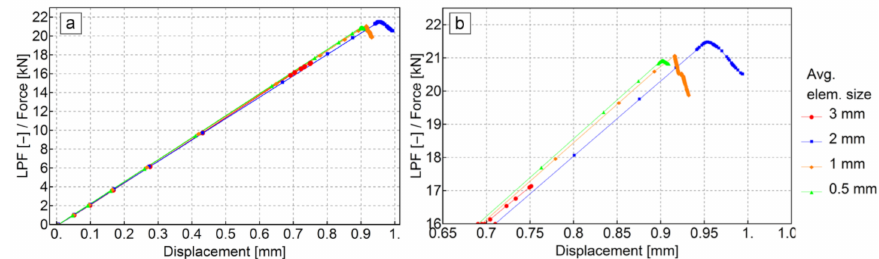
Figure 12. Load versus deflection curve comparison for di ff erent mesh densities of the axisymmetric model: ( a ) full structure response, ( b ) zoomed-in view of the failure region.